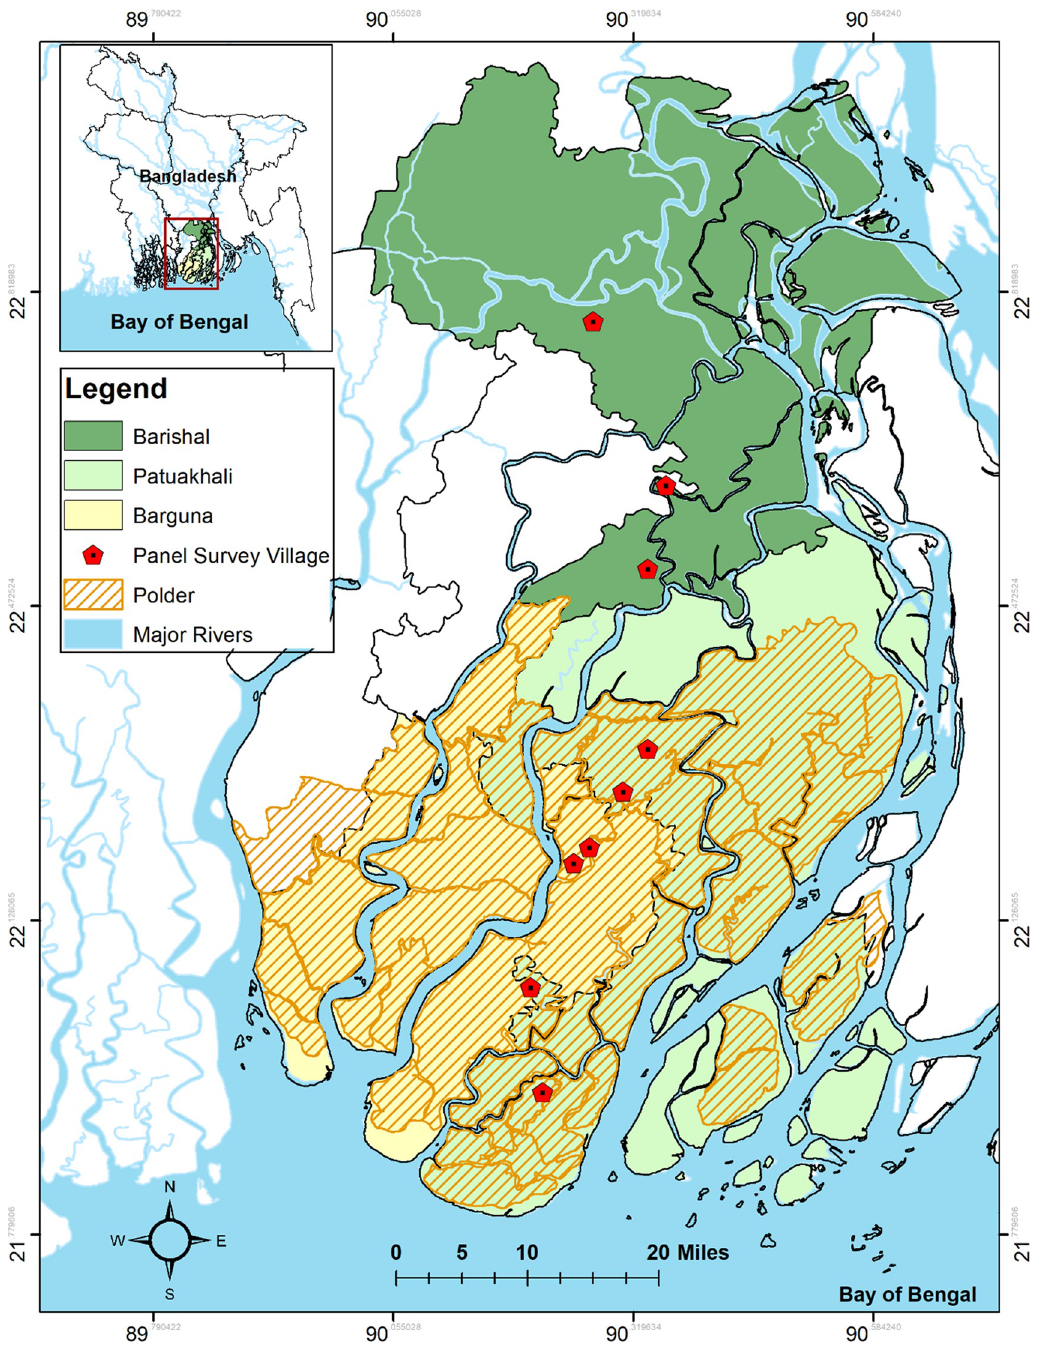
Fig 1. Map of the study area in south-central coastal Bangladesh. The districts covered by surveys are displaying salinity differences as well as the systems of polders.